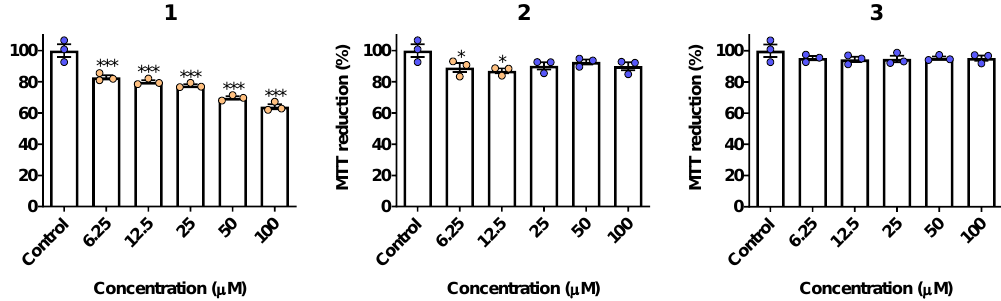
Figure 8. Viability of HaCaT cells treated with 1 – 3 for 24 h at the concentrations presented. * p < 0.05, *** p < 0.001.